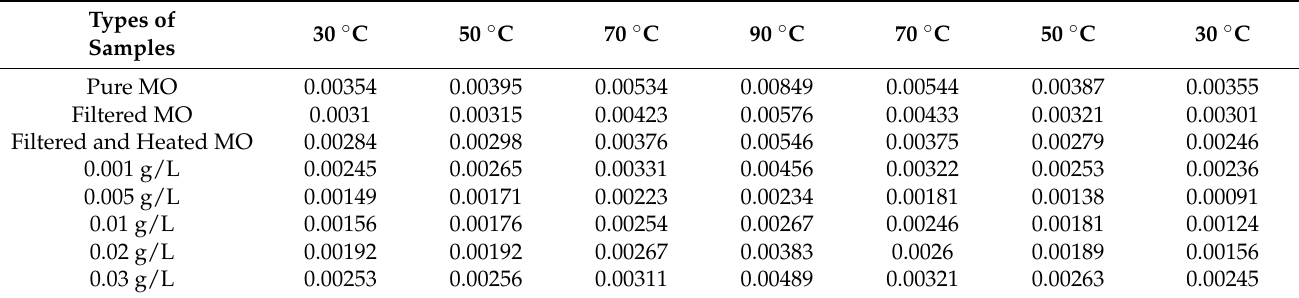
Figure 8. Dissipation factors of different types of samples. Table 4. Dissipation factor values of different types of samples with temperature increasing from 30 °C to 90 °C and falling to 30 °C.